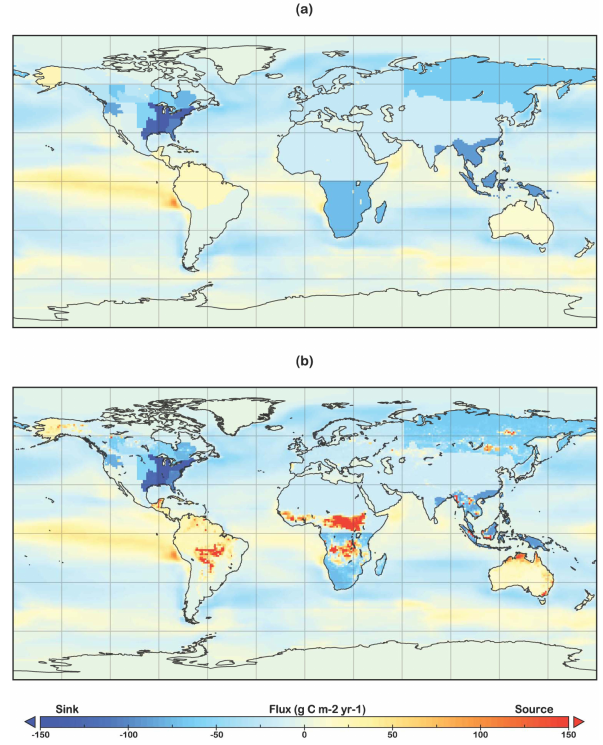
Fig. 2. Map of mean posterior carbon flux for 2002-2007 derived in this study, (a) excluding fossil fuel and biomass burning emissions, and (b) excluding only fossil fuel emissions. The a priori ocean exchange and biomass burning emission are considered at 1 × 1 ◦